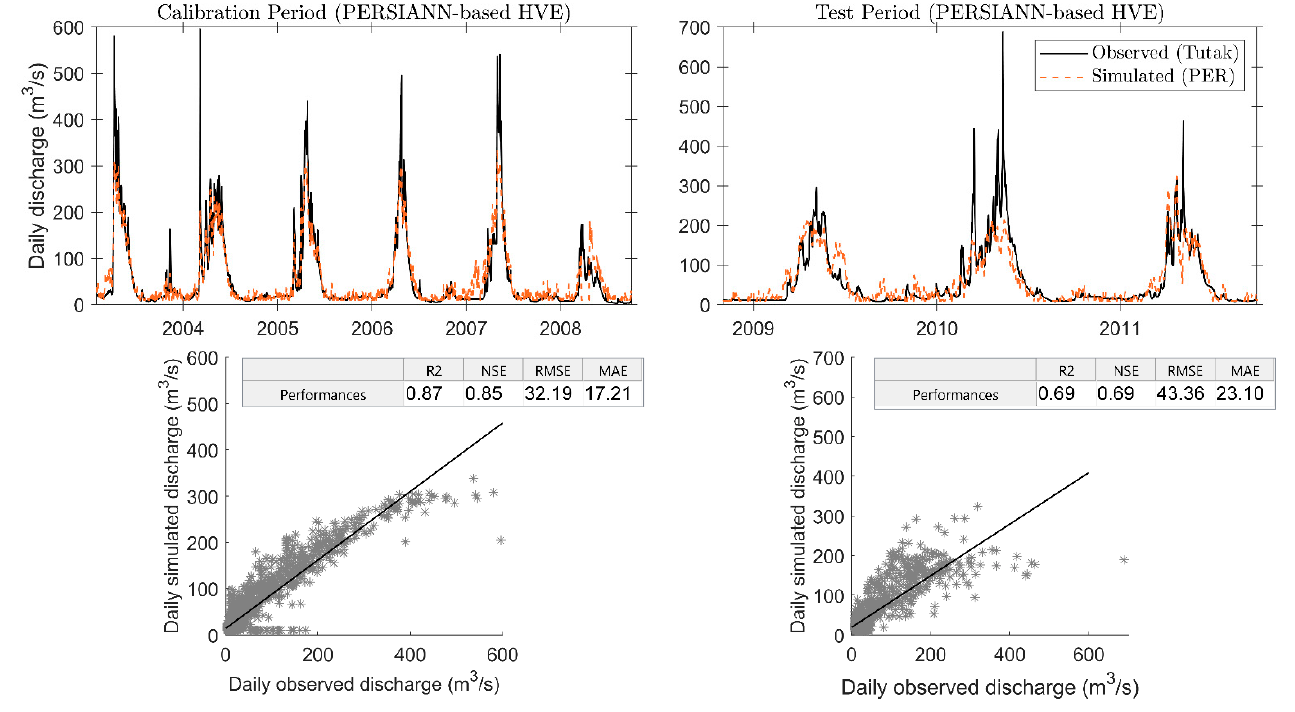
Figure 10. HVE results using PERSIANN SBP data.